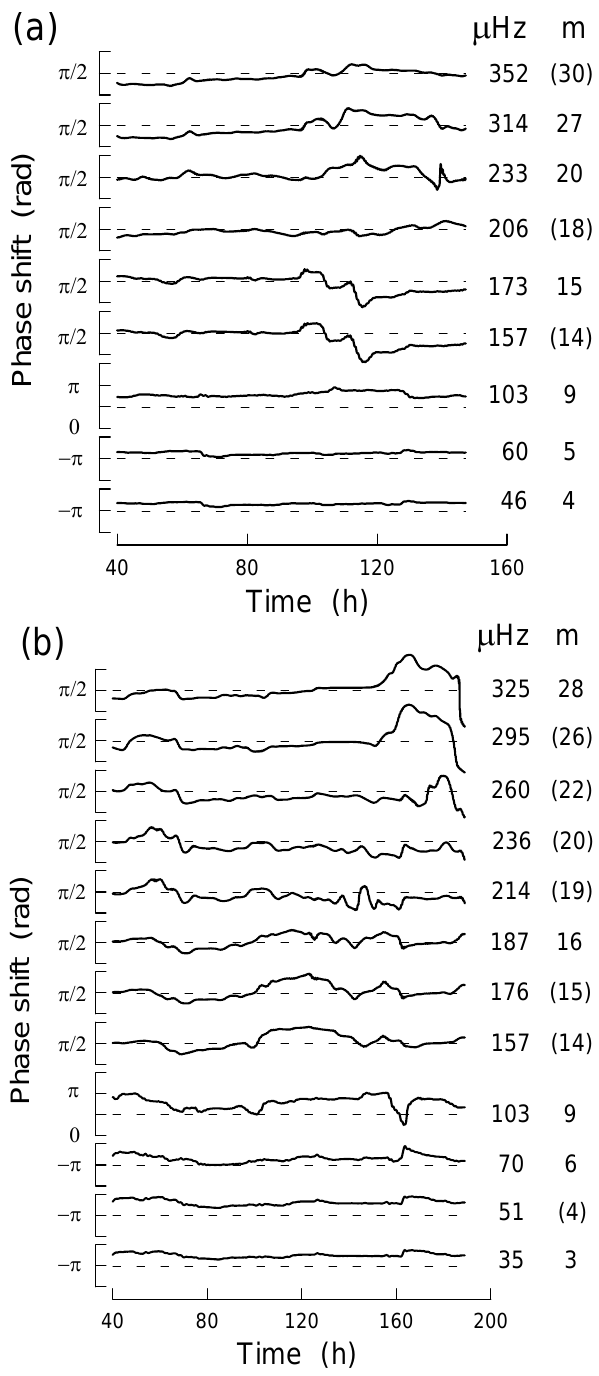
Fig. 10 b. Fig. 10. Phase shift between oscillations, detected simultaneously by microbarometer and seismometer measurements during 17–23 October (a) and 28 October–4 November (b) 1997. The time is counted from the beginning of records. The numbers at a line indi- cate both the frequency of oscillations and the number of solar tidal subharmonic which is the closest to the oscillation in frequency. This number is bracketed if the oscillation frequency is displaced from the subharmonic frequency more than 2µHz.